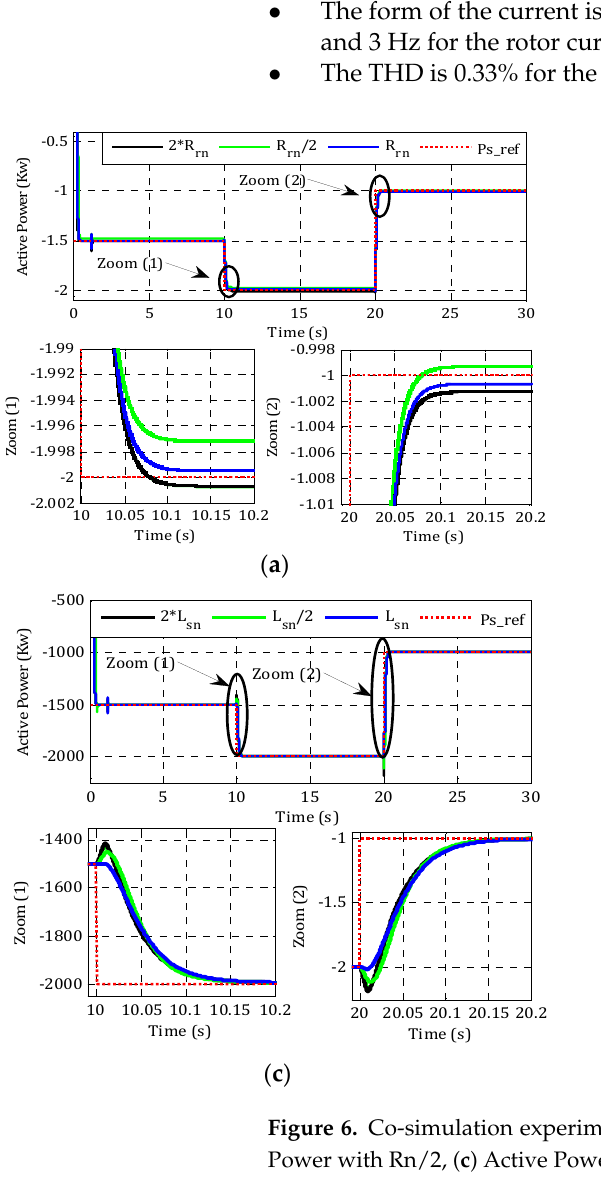
other techniques. Additionally, it presents acceptable results in terms of rapidity and pre- cision compared to other methods, which are characterized by Error = 0.15% and Tr = 0.015